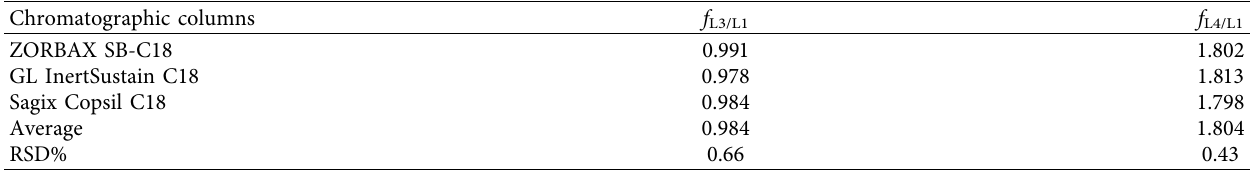
Table 6: Effect of different brands of chromatographic columns on f.